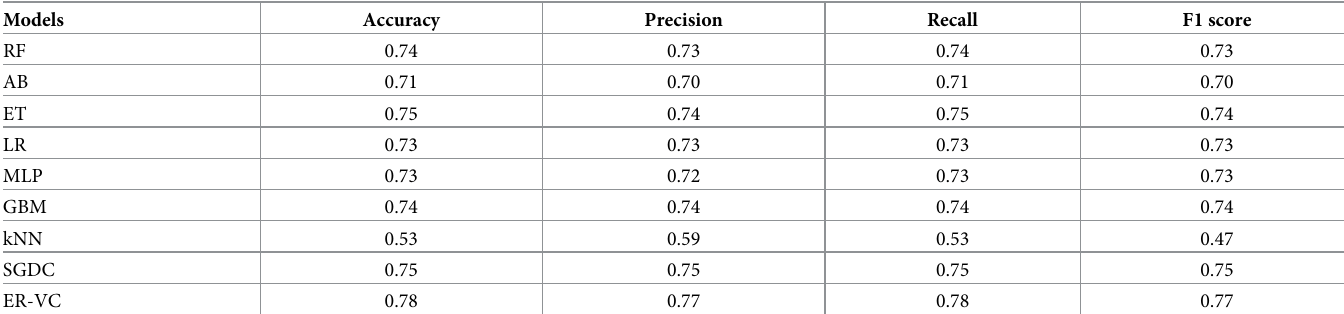
Table 10. Classification results of machine learning models using BoW with ADASYN. Models